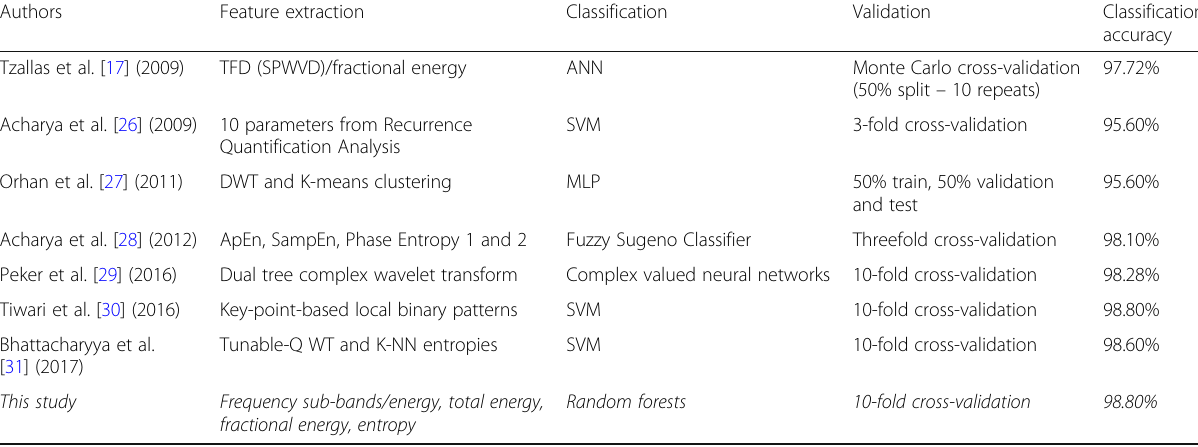
Table 8 Comparison of methodologies presented in the literature for the three-class (ZO-NF-S) problem